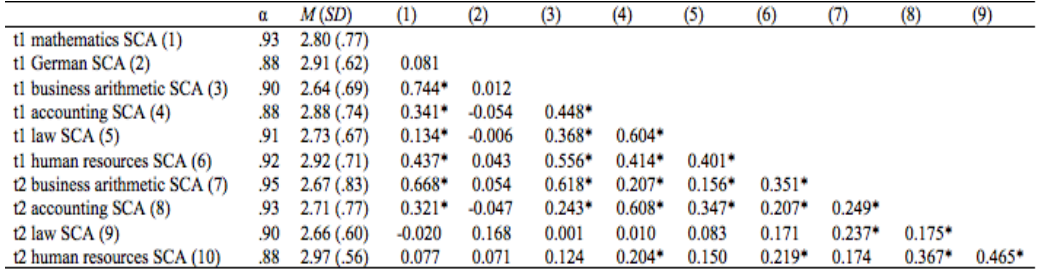
Internal Consistency, Descriptive Statistics, and Latent bivariate Correlations Across All Self-Concepts